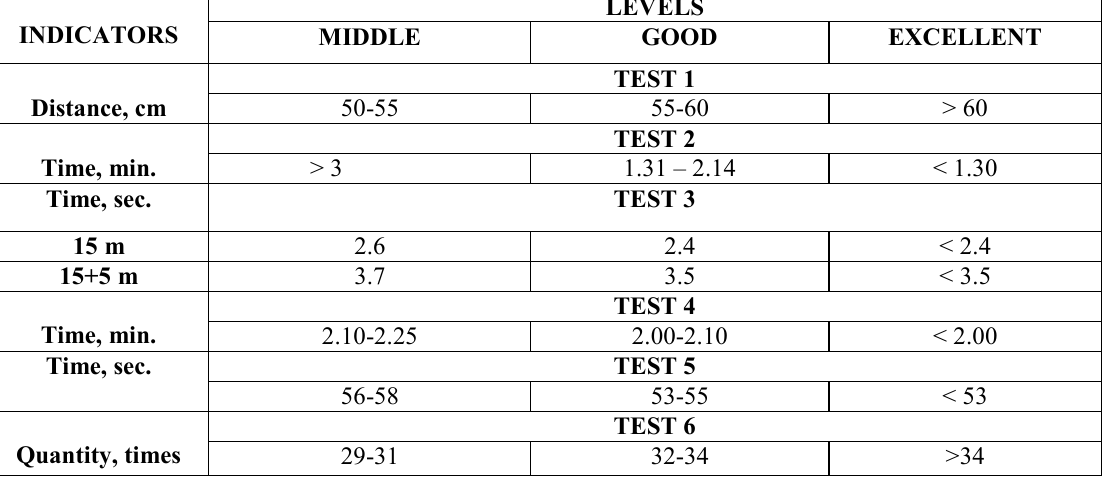
Model characteristics of indicators of control over qualified handball players’ training functioning INDICATORS